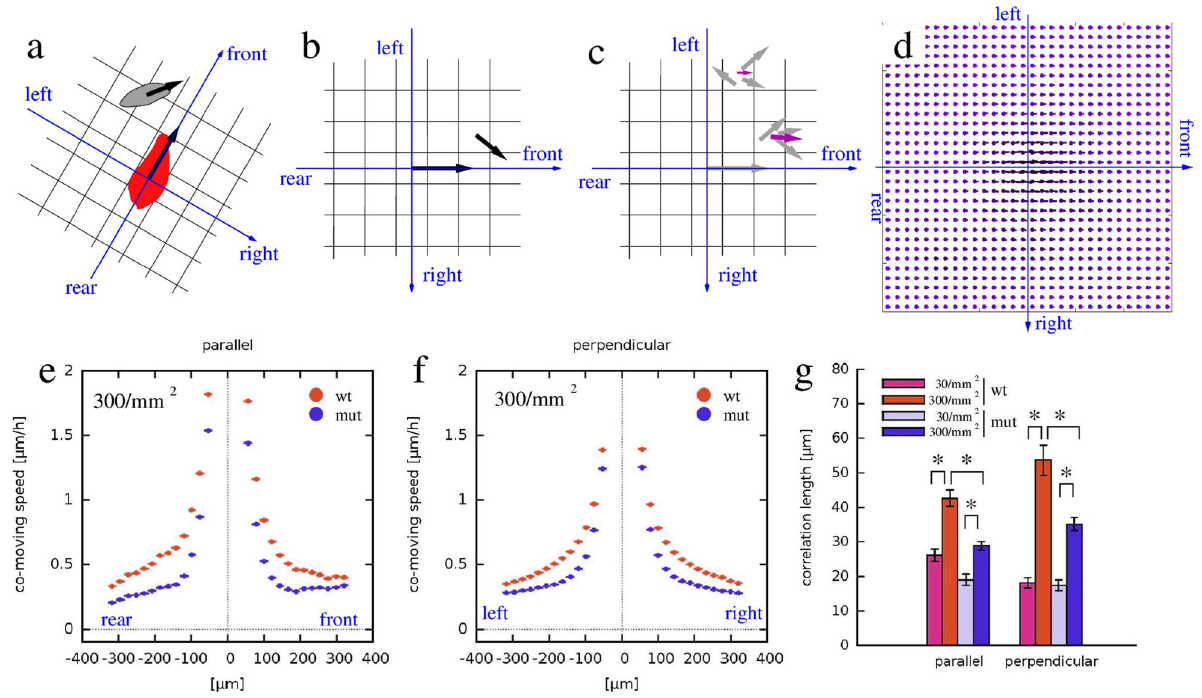
Figure 7. Specc1l cGT/ΔC510 mutant MEPM cells exhibit a collective migration defect in 2D random motility assays. ( a – d ) To characterize spatial correlations in cell motility, we determined the average co-moving velocity at various locations relative to an average motile cell. ( a ) For each moving cell (red) we determined the relative position and velocity of every other cell (gray) within the vicinity. ( b ) The velocities were assigned to bins of a coordinate system, co-aligned with the moving cell. ( c ) By repeating this procedure for multiple cells and multiple time points, each bin contained multiple velocity vectors (gray). The average velocity vector in each bin (magenta) was indicative of the spatial correlation: the average of random vectors was close to zero, while it was non-zero when velocities shared a common component. ( d ) The average velocity map thus characterized the typical cell velocities at various locations relative to a moving cell. We sampled this field along the front-rear axis and also along the left–right axis ( e , f ). ( e,f ) MEPM cells in high density cultures tended to move locally in the same direction, indicated by positive average co-moving speed values—both along the front-rear ( e ) and lateral ( f ) axes. Data were averaged from 4 independent fields, both for WT (orange) and Specc1l -mutant (blue) cells. The co-movement of Specc1l -mutant cells, however, diminished at a closer distance than that of WT cells. ( g ) Average correlation lengths, both parallel with and perpendicular to the direction of cell motion, were established by fitting an exponential function on the profiles shown in ( e , f ). High-density cultures (orange and blue) showed a significantly increased correlation length compared to low-density cultures (pink and grey). The increase, however, was approximately twice as large in WT cells (pink vs orange) than in Specc1l -mutant cells (grey vs blue). Significance values of the differences were established by Welch t-tests, and are summarized in Supplemental Table